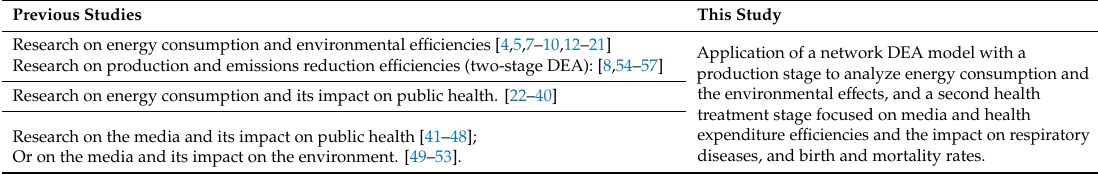
Table 1. Comparison of previous studies and this